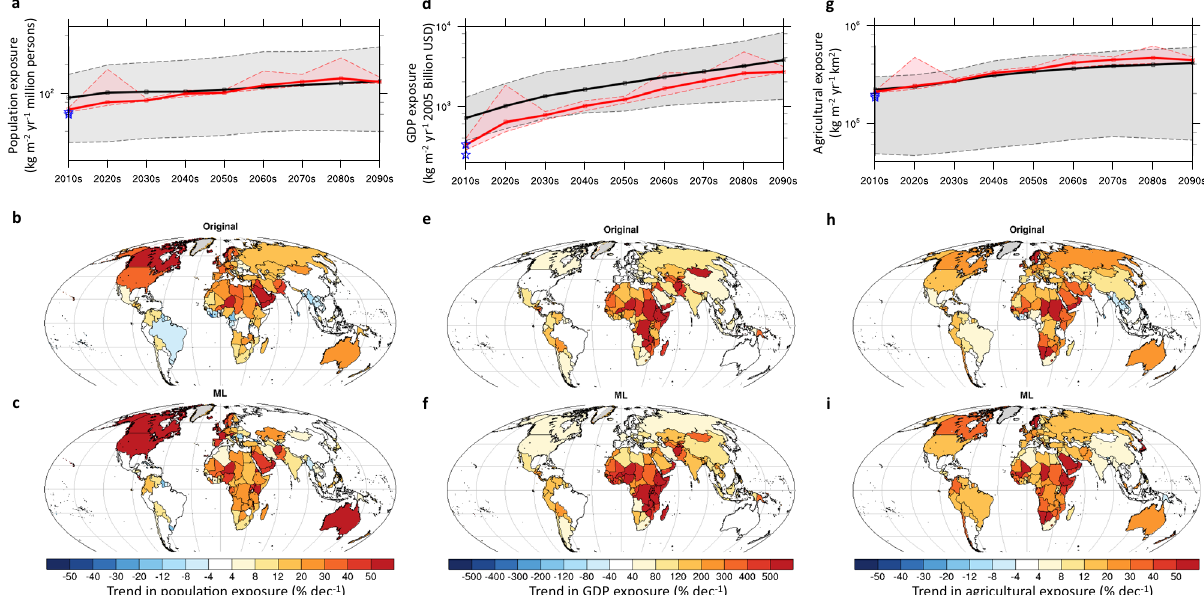
Fig. 4 Global and national evolution of socioeconomic risks from wild fi re carbon emission during the 2010s to 2090 s. a Original (black line with gray shading) and observation-constrained (red line with pink shading) time series of global total exposure to fi re carbon emission in a . population (kg m − 2 yr − 1 million person), d gross domestic product (GDP) (kg m − 2 purchasing power parity 2005 billion USD y − 1 ), and g agricultural area (kg m − 2 km 2 y − 1 ). The blue stars indicate the observed exposure to fi re carbon emission in population, GDP, and agricultural area, respectively, during the 2010s. The lines represent the multimodel ensemble mean. The shadings represent the 10th and 90th percentiles among ensemble members. b , e , h original and c , f , i observation-constrained ensemble mean, national trend in the socioeconomic exposure to fi re carbon emission in b and c population, e and f GDP, and h and i agricultural area. The trend is presented by the ratio between the projected trend and the exposure during the 2010s (% decade − 1 ), indicated by either the b , e , h original or c , f , i observation-constrained